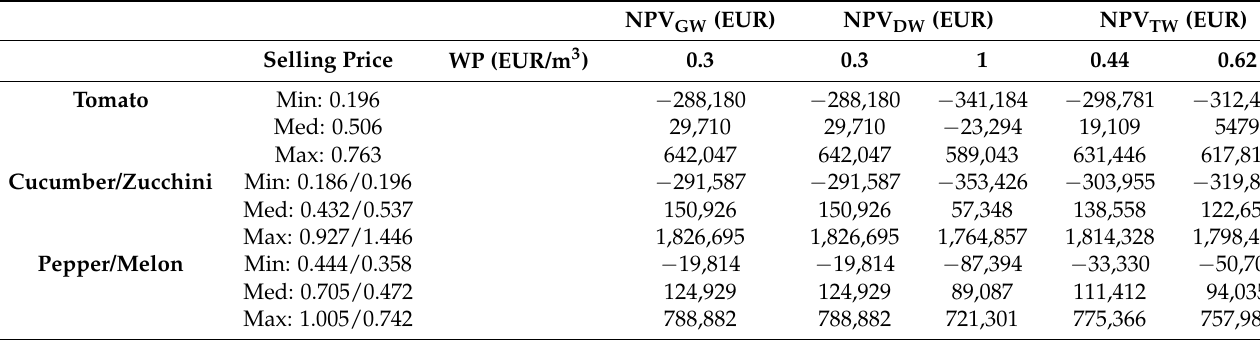
Table 8. NPV of three different crop alternatives with diverse water